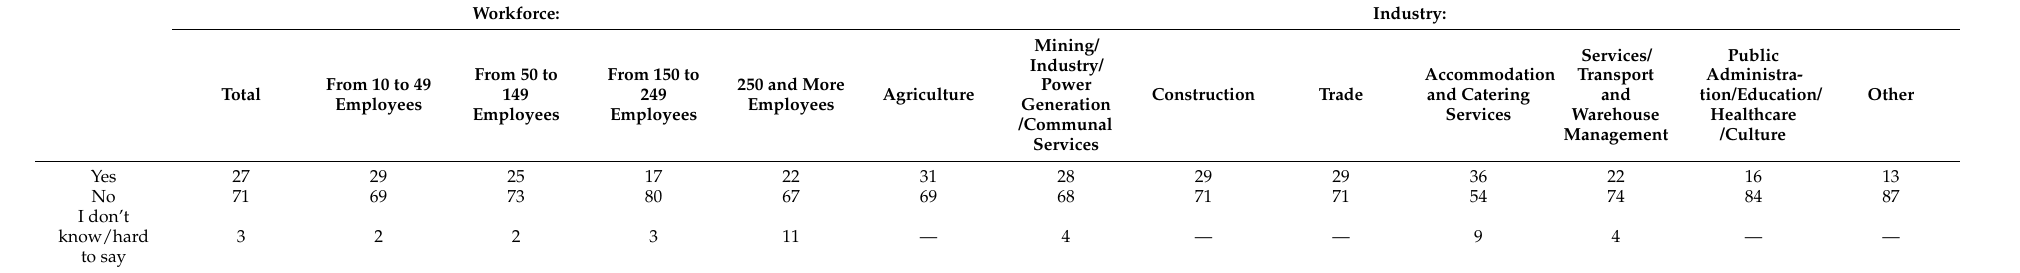
Table 3. Increasing temperature in Poland is nothing terrible as, thanks to this, we have mild winters and sunny summers (in percentage points).